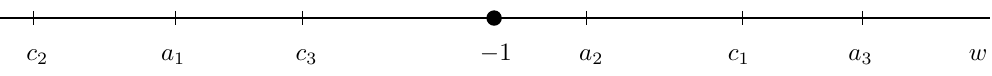
Figure 20. Locations of the various functions of j (cid:21) j in (5.10) on the w -line for all values of j (cid:21) j